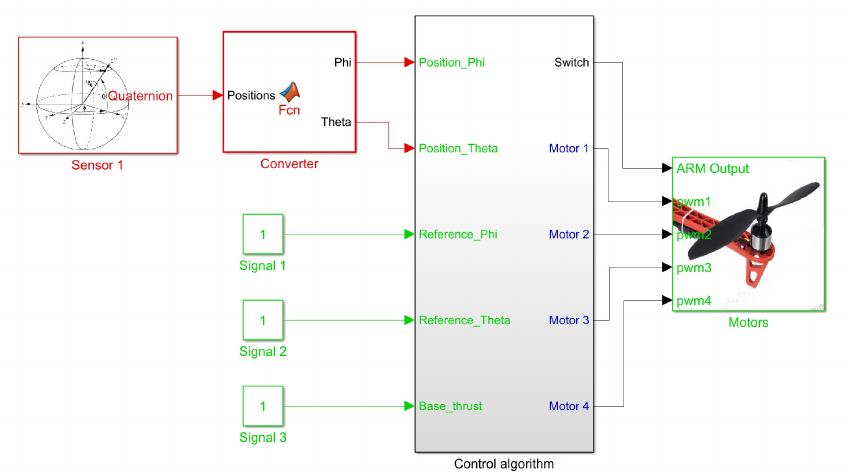
Figure 20. Simulink block diagram for PID controller implementation.